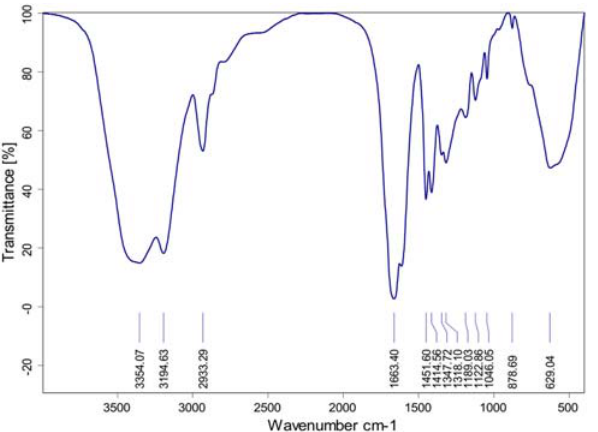
Figure 1: FT - IR spectrum of PDAA